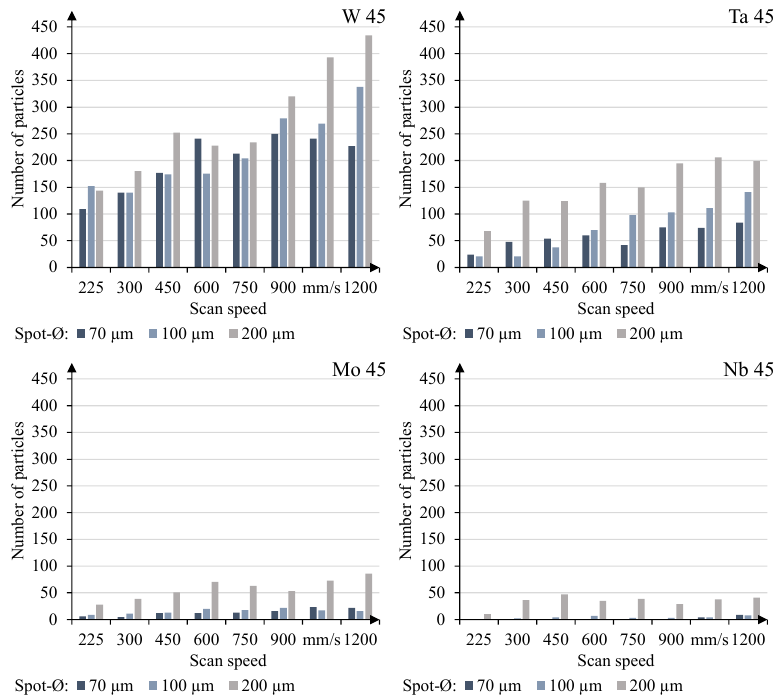
Figure A1. Results of experiments series 1 (also see Table 2); measurement area 3.8 mm 2 .